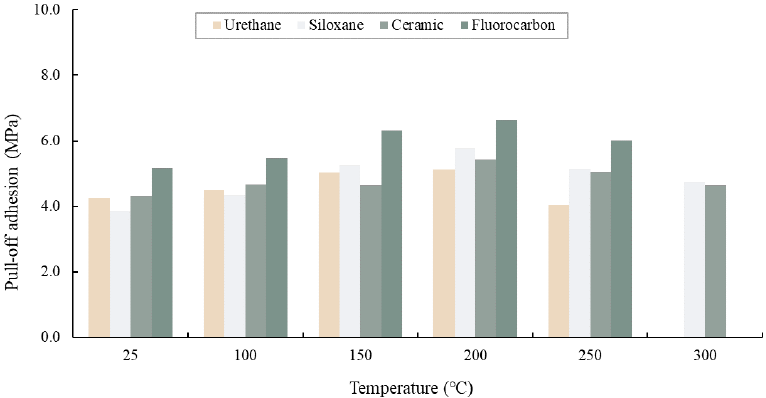
Figure 7. Pull-off adhesion according to heating temperature.